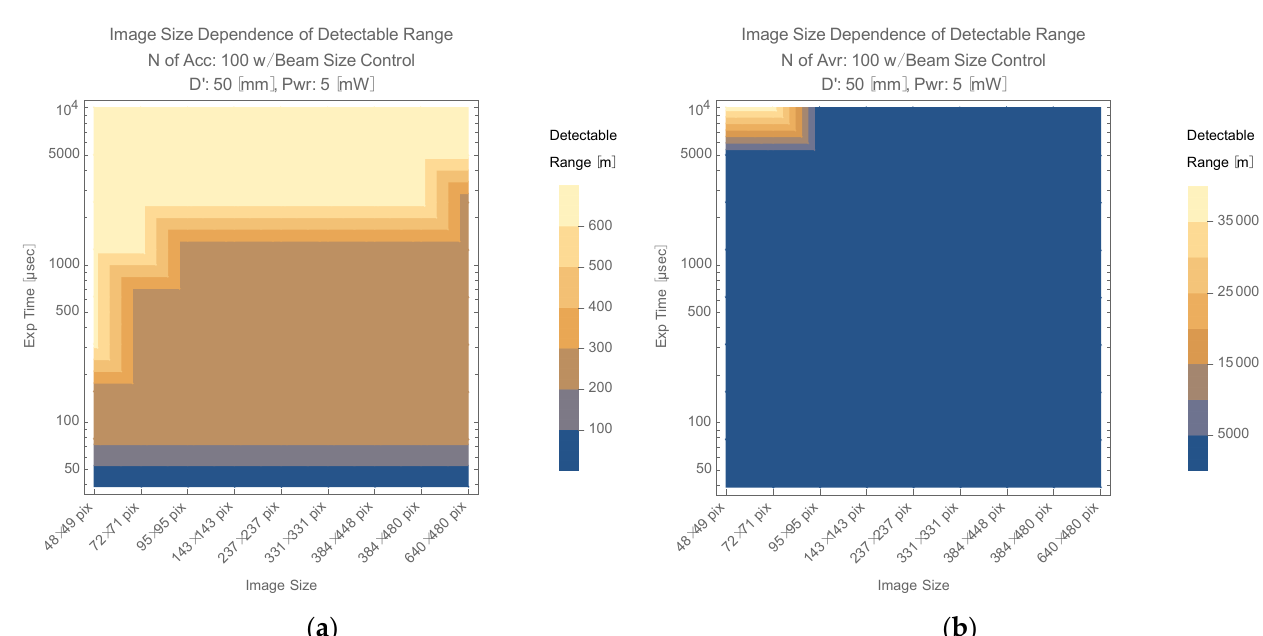
Figure 10. Detectable range plot for a 50 mm receiver diameter with beam size control: ( a ) 100 accumulation; ( b ) 100 averaging.